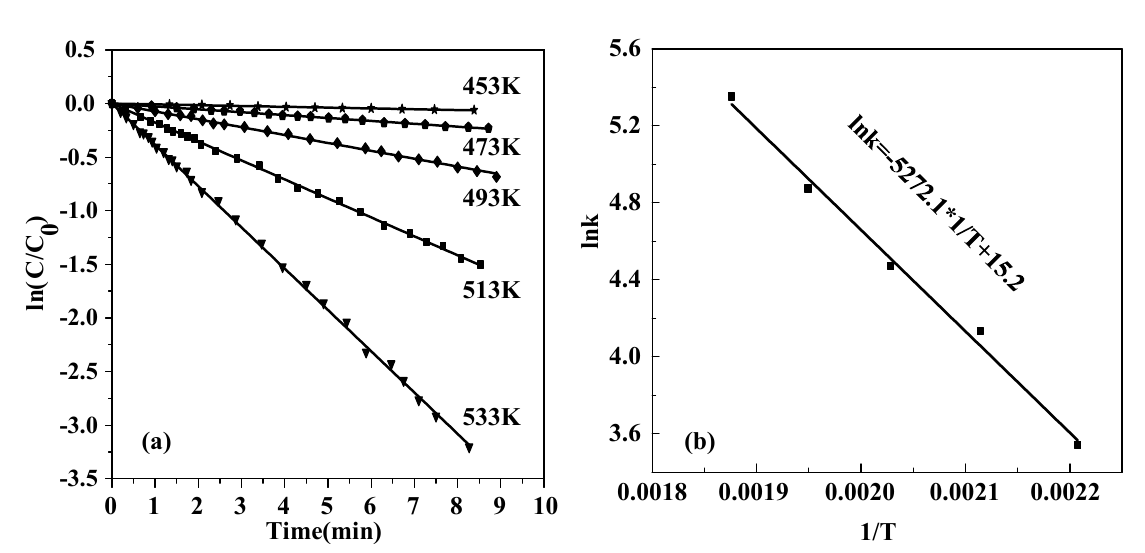
Figure 6. ( a ) ln(C/C 0 ) versus time for 3.0 wt% Pd/CNTs at 453, 473, 493, 513 and 533 K; ( b ) lnk versus 1/T for 3.0 wt% Pd/CNTs at 453, 473, 493, 513 and 533 K.